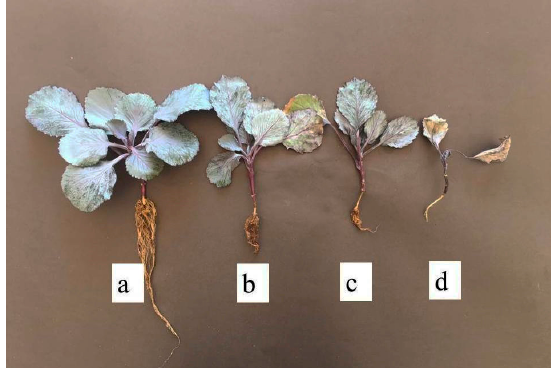
Figure 7. Different disease symptoms caused by isolates belonged to different AGs of Rhizoctonia